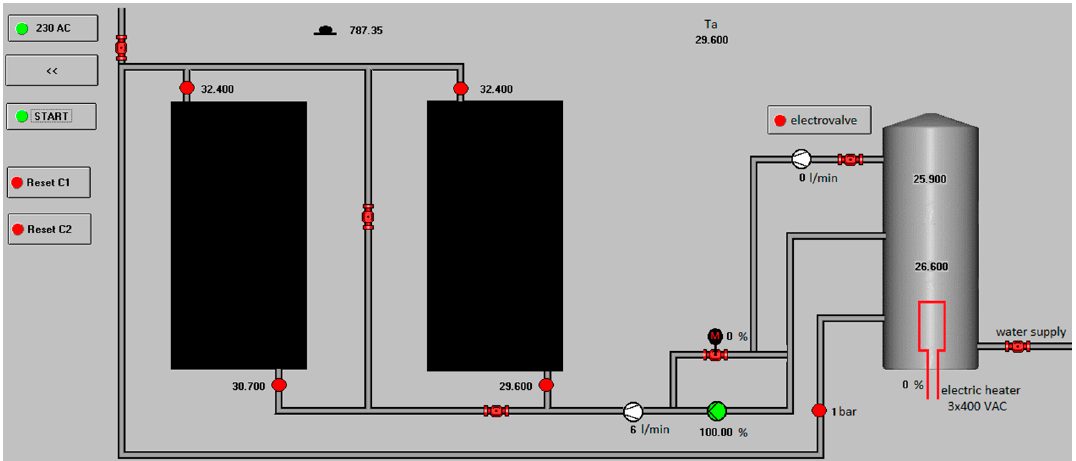
Figure 3. Test stand (system I).